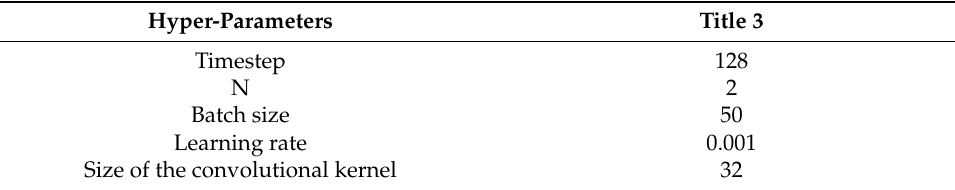
Table 4. The hyperparameter selection results of prediction model.